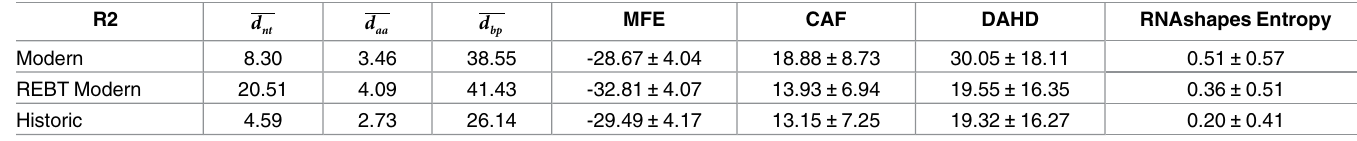
Table 3. Measuresof diversity and plasticity for Modern, REBT (random) Modern, and Historic R2 sets. R2 d